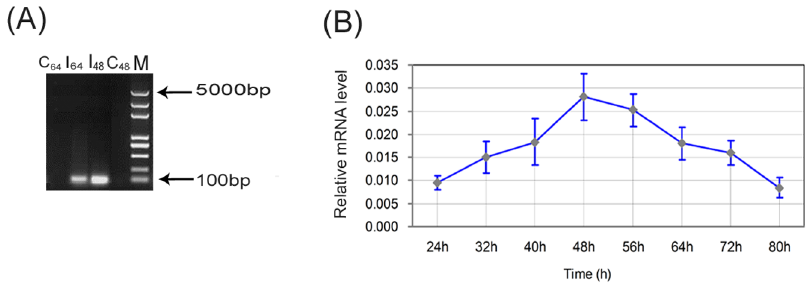
Figure 2. Validation of TGEV virus infection of ST cells. (A) RT-PCR validation of TGEV infection in ST cells at 48 hpi (I 48 ) and 64 hpi (I 64 ) compared to the control at 48 h (C 48 ) and 64 h (C 64 ). A marker (M) was used to identify fragment size. (B) qRT-PCR analysis of changes in TGEV mRNA expression levels in the ST cells over time. The changes in mRNA expression level at the various time points is indicated, and show that the expression level of TGEV increased gradually, reaching a peak at 48 h, then decreased dramatically. Values are the means of three repeated experiments. The error bars in the graphs represent the standard deviation.